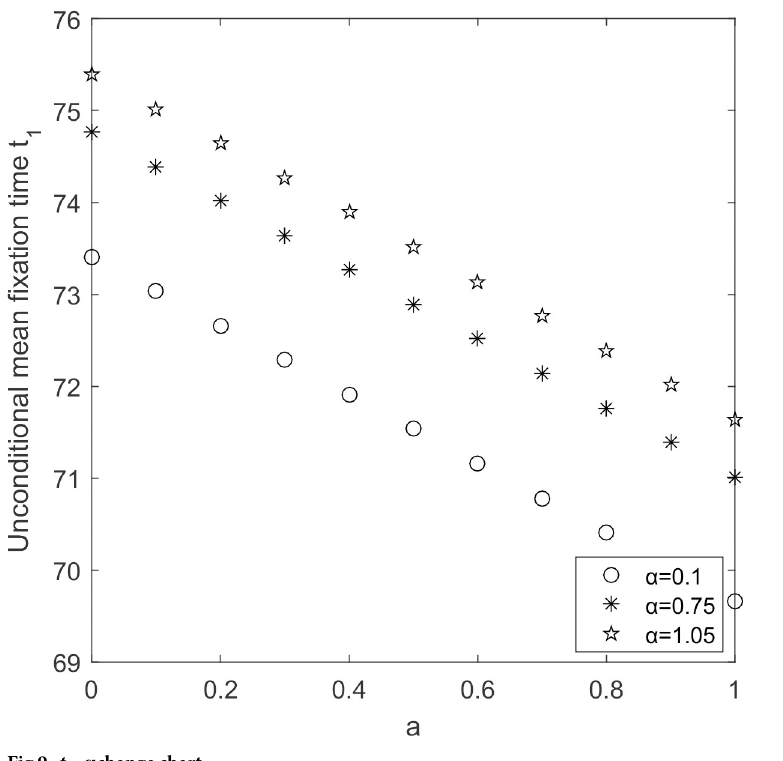
Fig 9. t 1 ~ α change